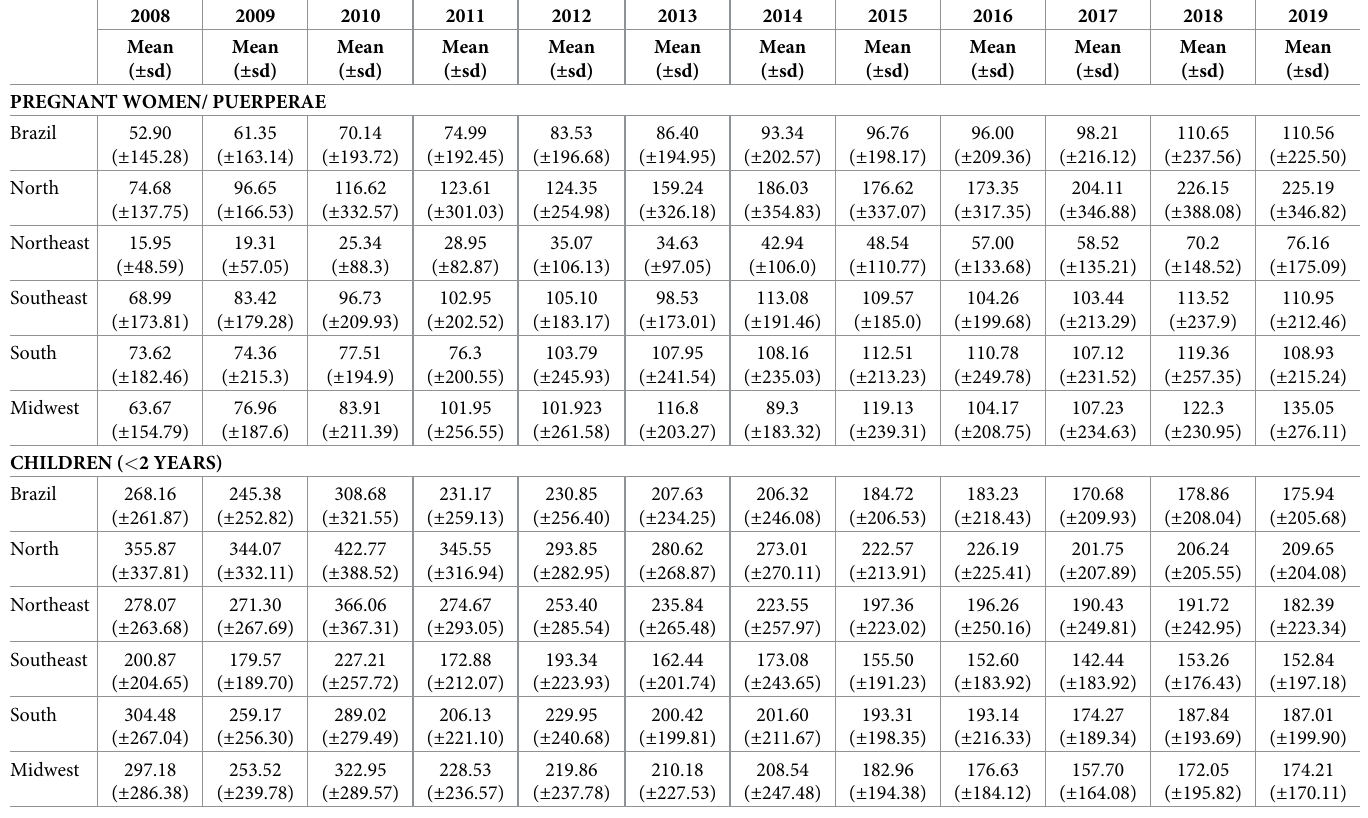
Table 1. PCSC rate in pregnant women, puerperae, and children under two years of age in Brazil and